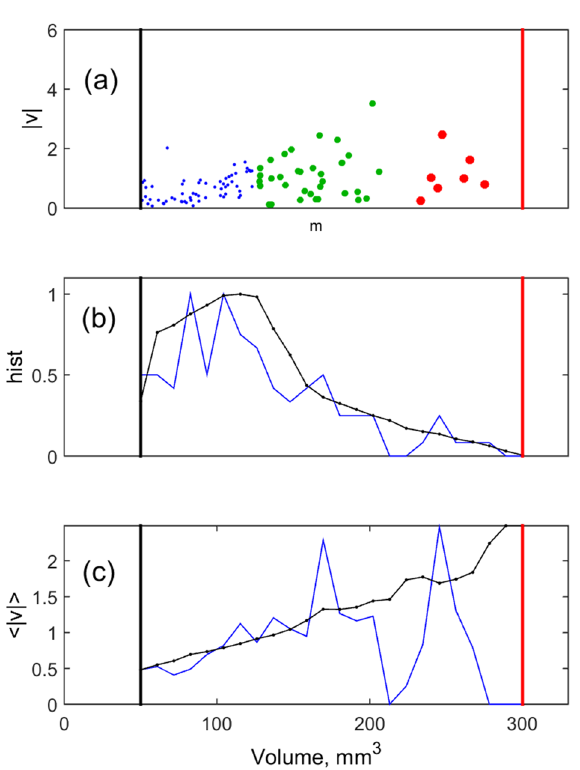
Figure 3. Mass depending values: ( a ) instant configuration of the velocities of different subgroups marked by the same symbols as in Fig. 1; ( b ) instant and long run averaged histograms of the masses for complete population; ( c ) instant and accumulated distributions of the velocities monotonously increasing with masses (volumes) of the